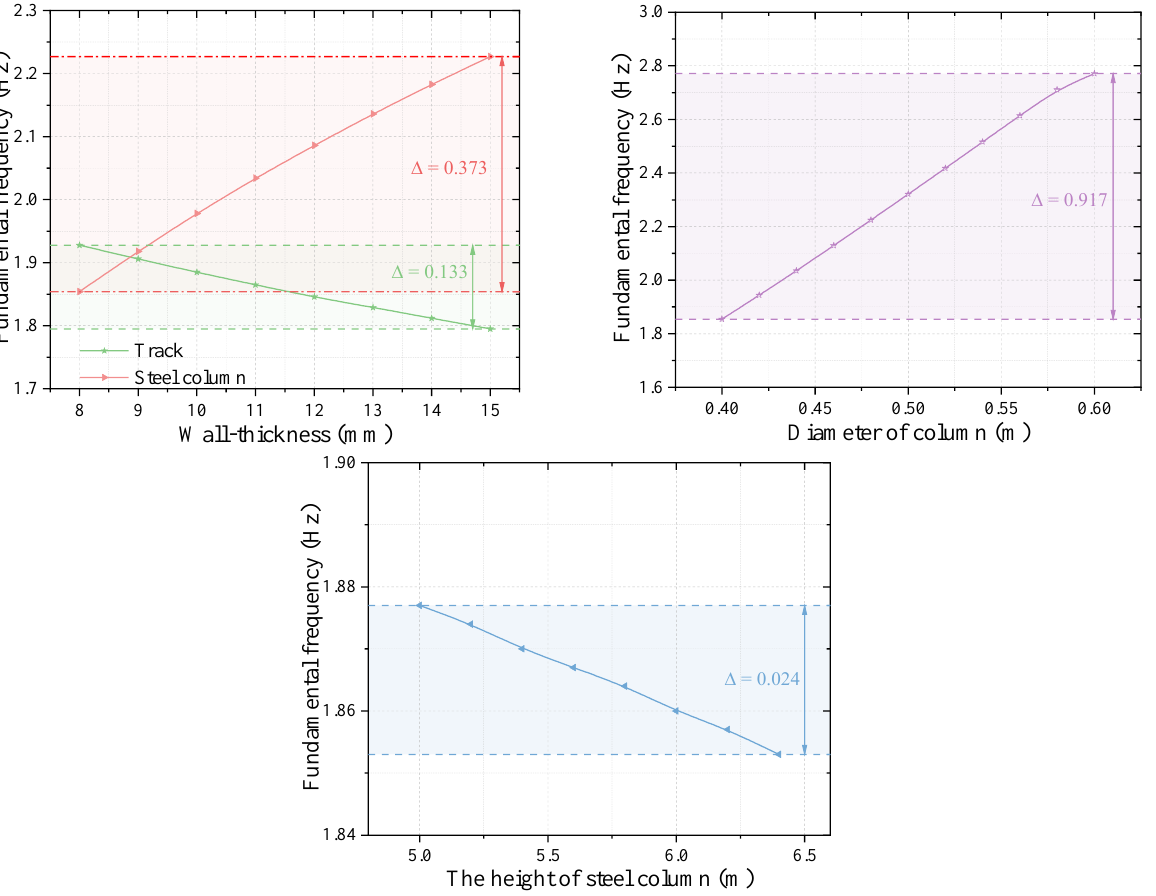
Figure 15. Change trend of fundamental frequency of structure.